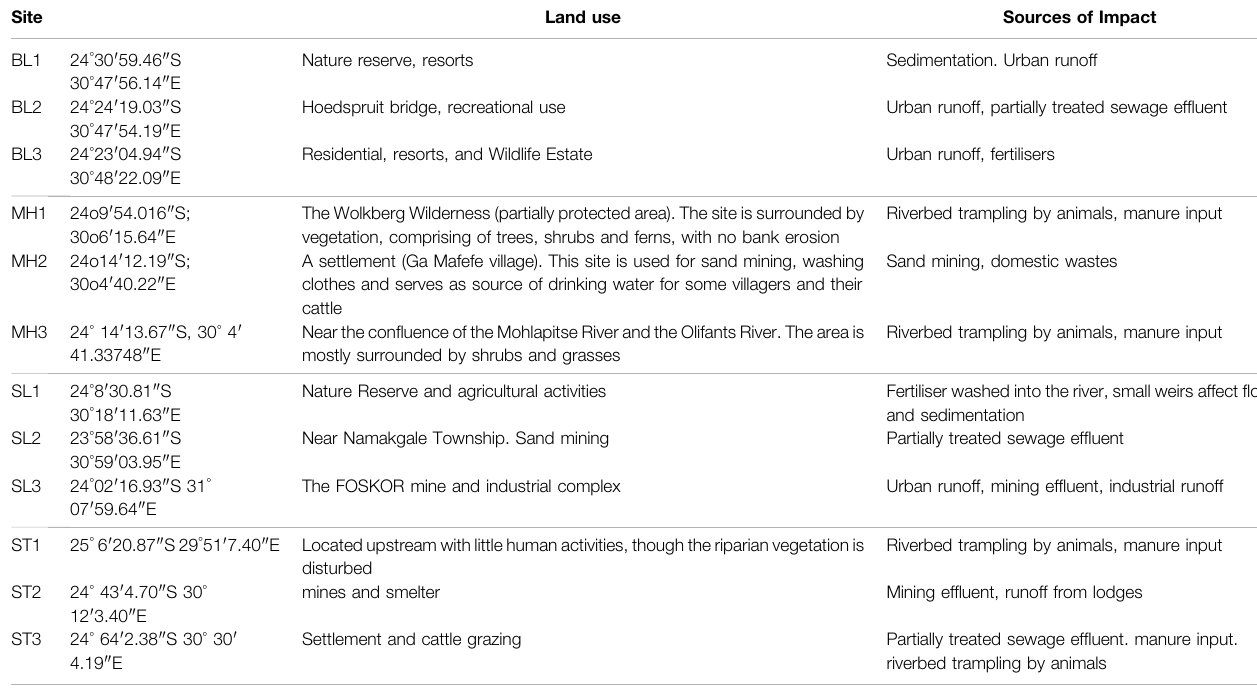
TABLE 1 | Description of the study sites of the selected four rivers in the Lower Olifants River Basin.